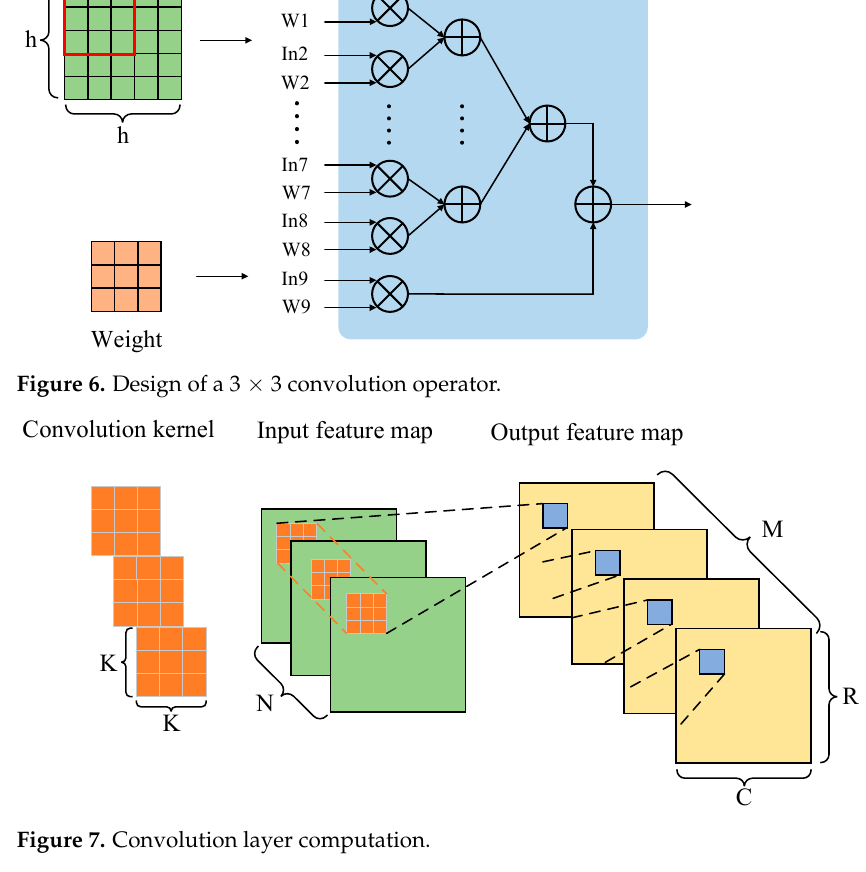
Figure 7. Convolution layer computation.